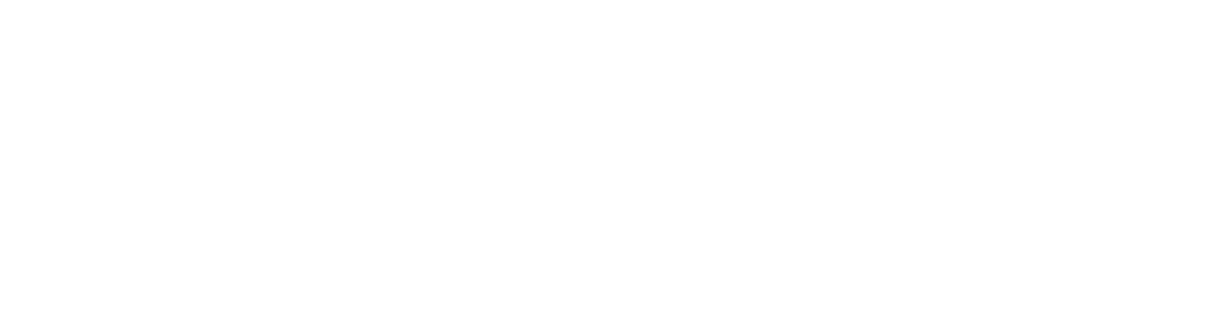
Frontiers in Pharmacology | Gastrointestinal